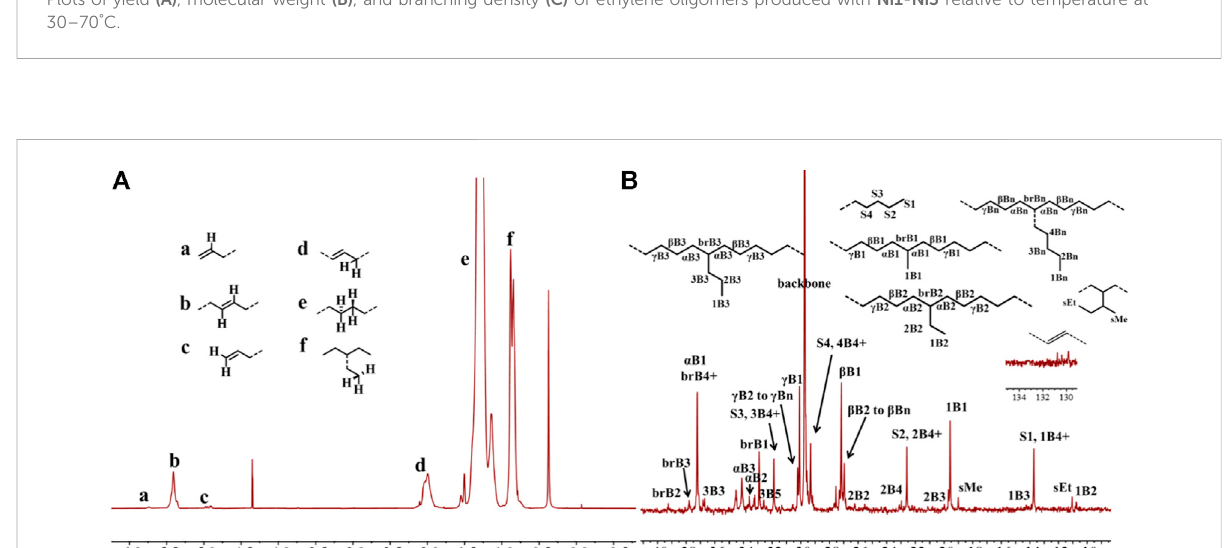
FIGURE 3 The 1 H (A) and 13 C (B) NMR spectral analyses of the hyperbranched ethylene oligomer obtained with Ni2 at 70 ° C. Assignments are numbered based on ref. Cotts et al., 2000; Randall, 1989; Galland et al., 1999. Supplementary Figures S1 − S4 are assigned to the chain ends. xBy delineates the branches, where x is the carbon, beginning with 1 at the methyl end and y is the branch length. brBy denotes the methine groups for branches with different